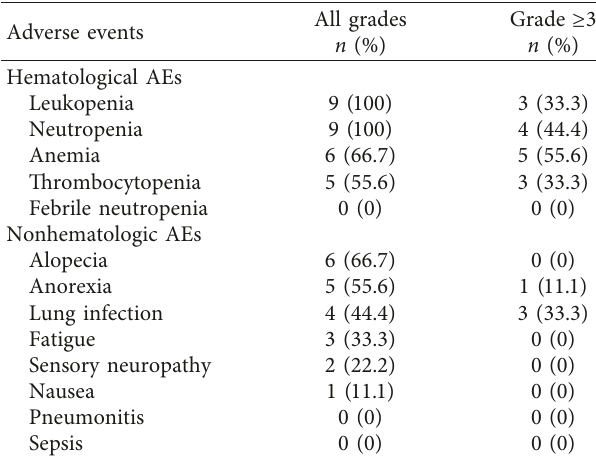
Table 1: Baseline patient characteristics. Table 2: Toxicities.